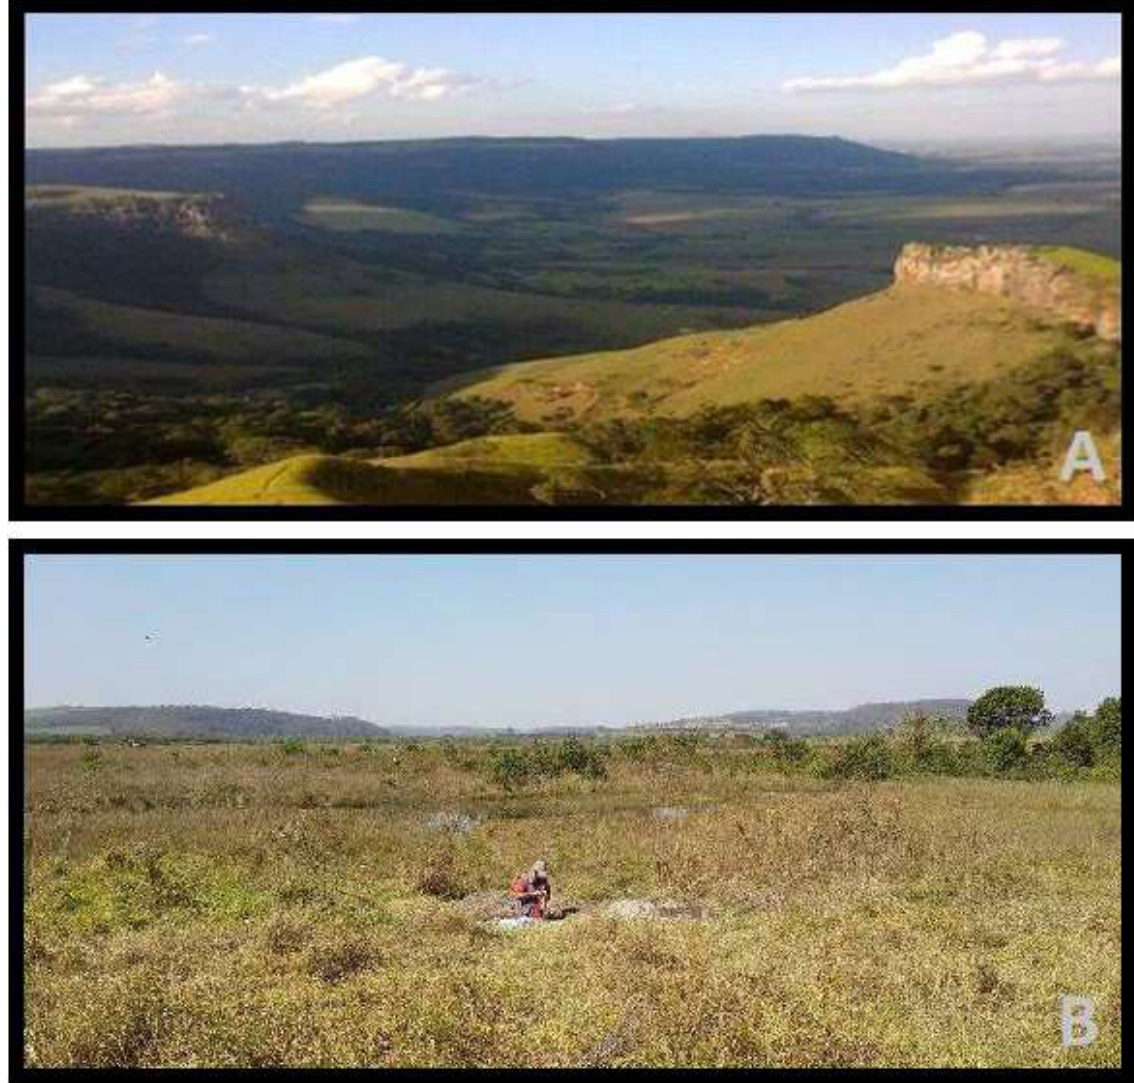
Figure 2. General aspects of the cuestiform segment in the São Paulo State, in the front of external escarpments view from South to North (A) and in the internalized set view from southwest to northeast(B), near BES II site. Source: adapted by Cheliz, photos by Franciely Oliveira (2015) and Fabio Grossi dos Santos